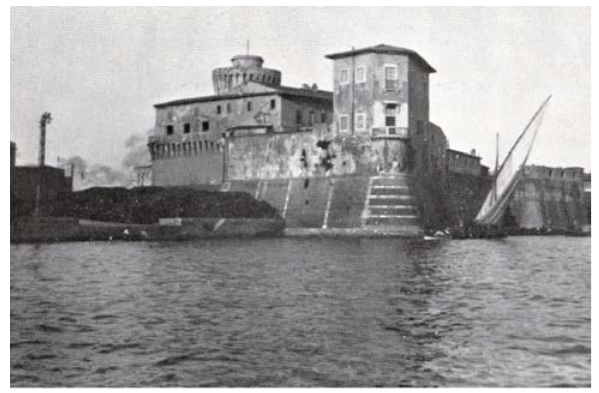
Figure 5: Archive image of the West side of Palazzo di Cosimo (Frattarelli Fischer 2018, 31)